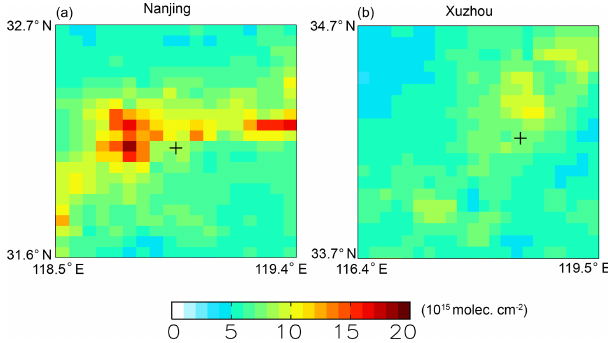
Figure 3. Spatial distributions of POMINO-TROPOMI NO 2 VCDs (on a 0 . 05 ◦ × 0 . 05 ◦ grid) around (a) Nanjing and (b) Xuzhou MAX- DOAS measurement sites in July 2018. The MAX-DOAS sites are marked as “ +